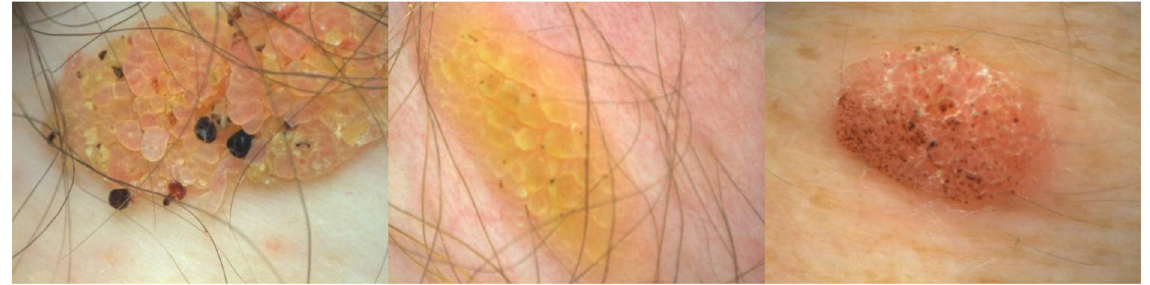
Figure 3. Clonal seborrheic keratoses. This figure is an original image created by the author for this publication and written informed consent was obtained from the